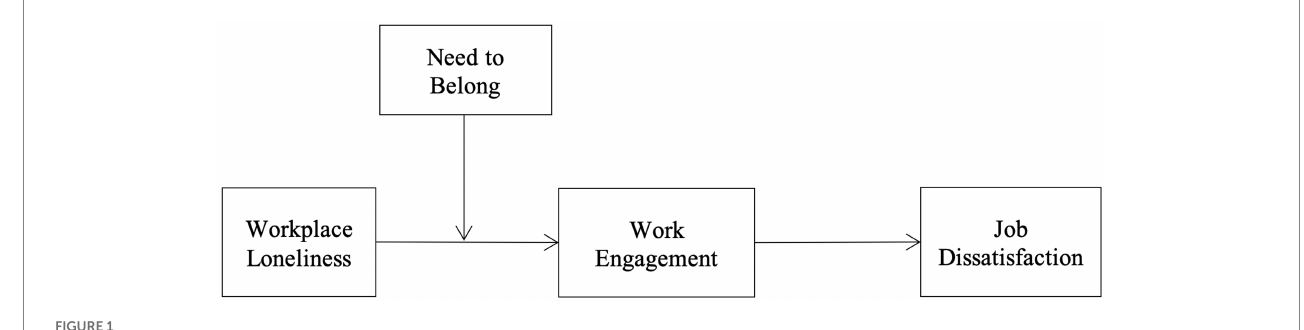
FIGURE 1 Conceptual